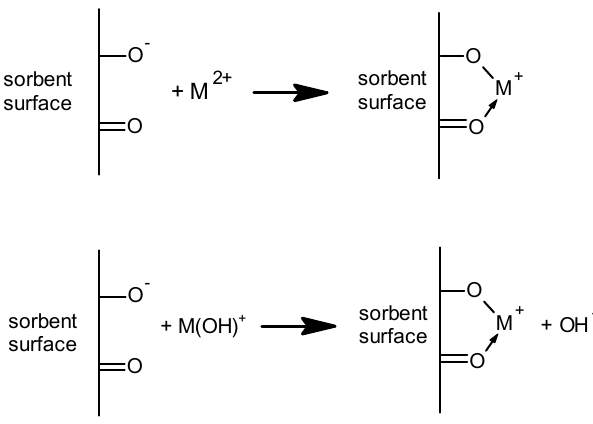
Figure 5. The sorption mechanism of metal ions on PVC-acac composites.